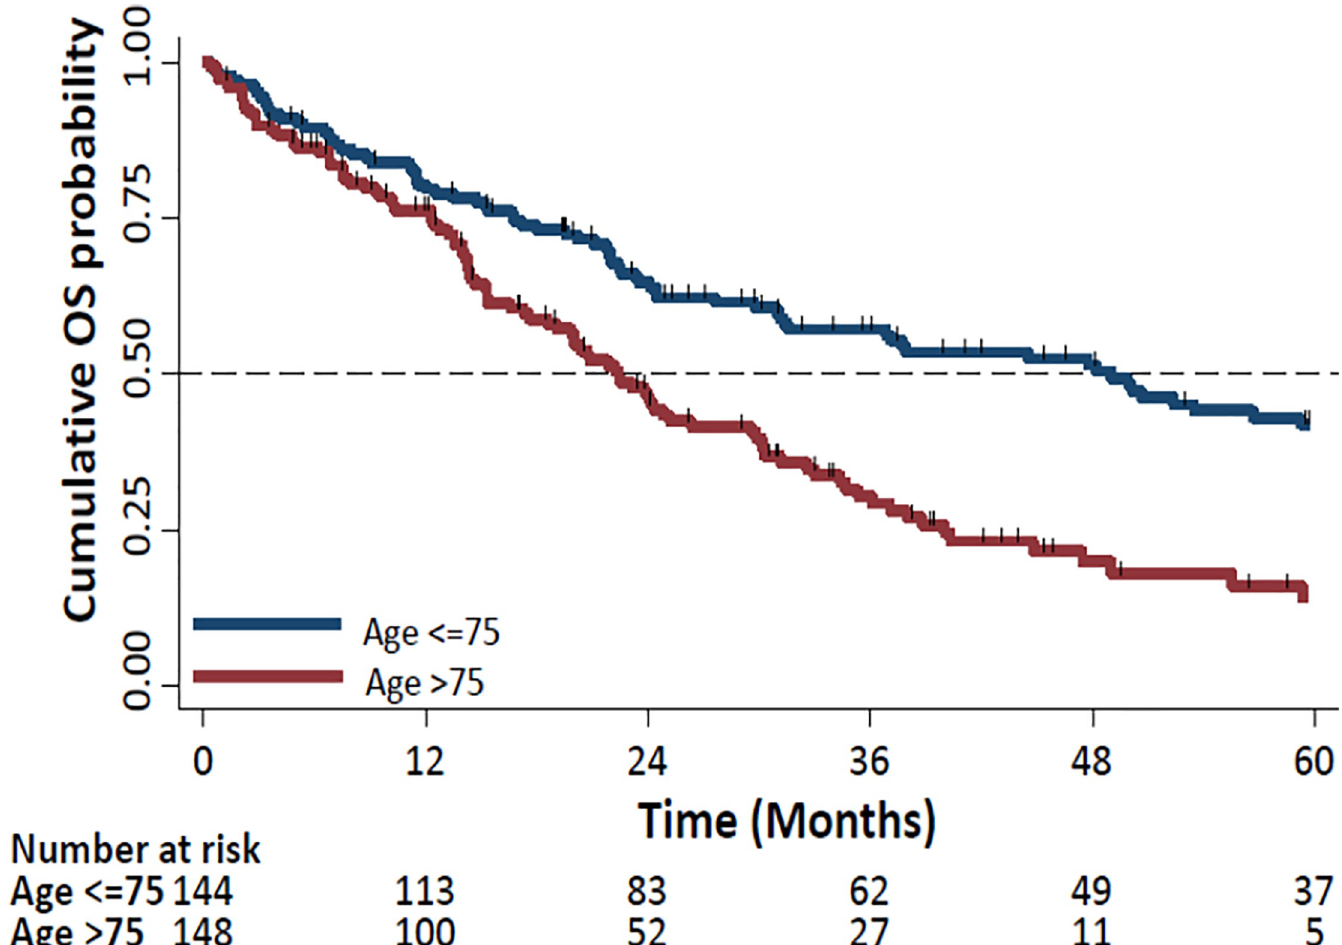
Fig 4. Kaplan Meier Curves of overall survival (OS) by age ( > 75 vs. � 75 years).